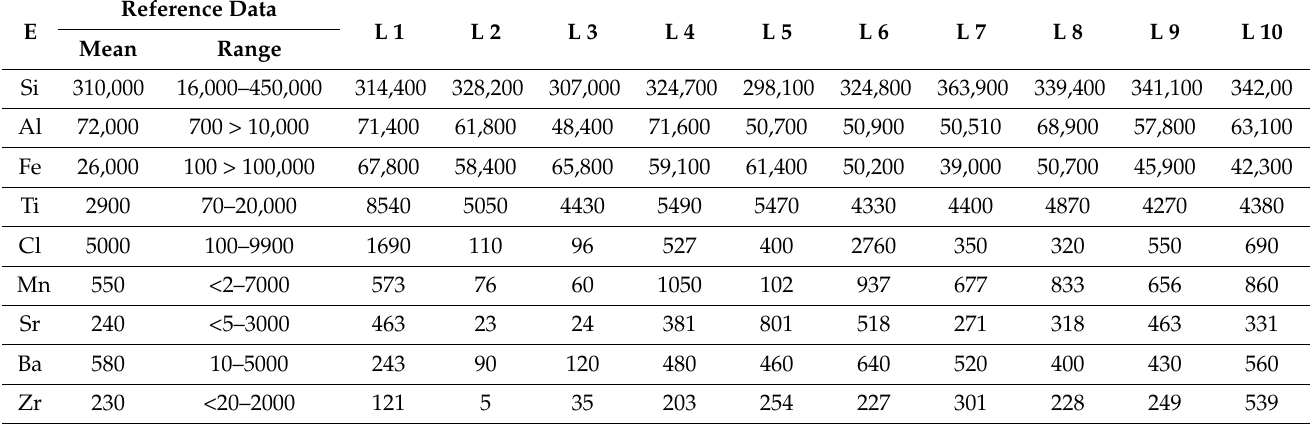
Table 1. Results of EDXRF analysis of micronutrients in samples of agricultural soils collected from the study area according to Koom et al. [44]. The data represent the mean value of element concentration (mg kg − 1 ). As there is no common LOD for an element, measured values below this limit were denoted “not a number” (NaN) value. (E) denotes element. The farms included in this study were designated from L1-L10. Reference element concentrations are based on Shacklette, Hansford [54], and Al-Mamoori et al. [55].